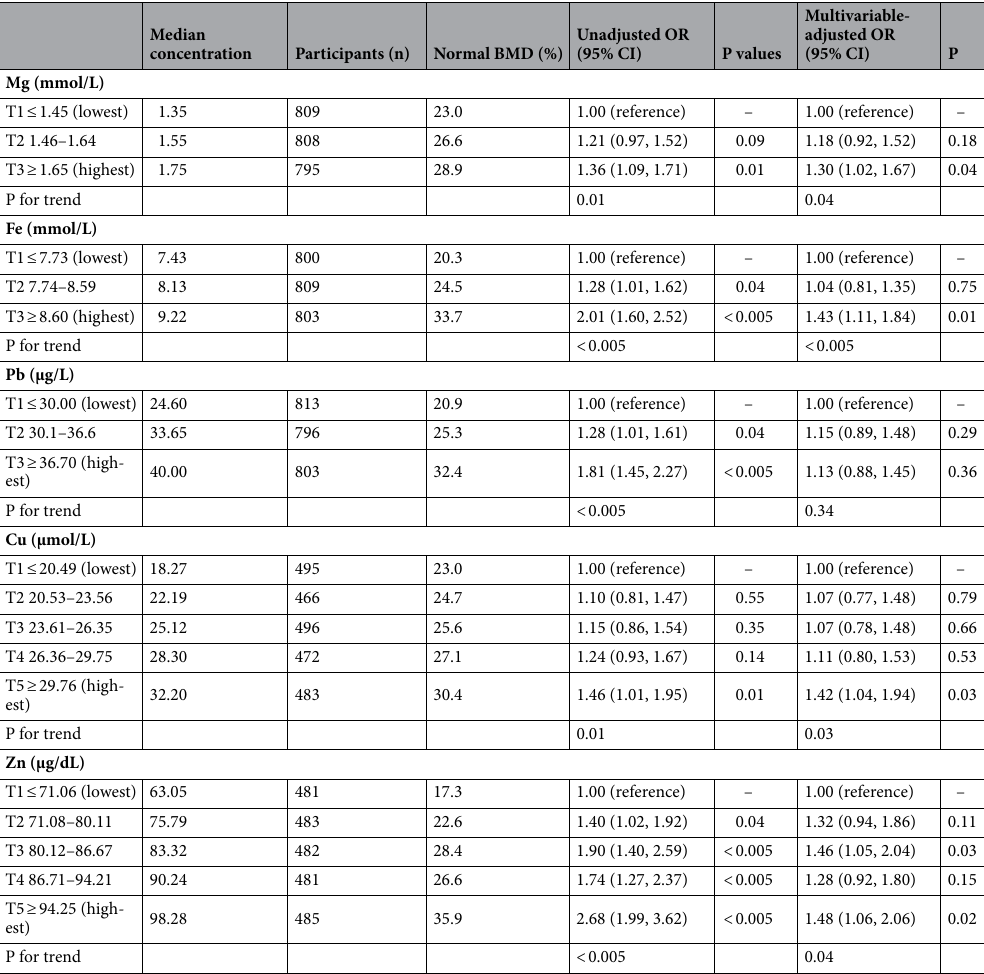
Table 3. Association between serum levels of trace elements and bone mineral density. Multivariable model was adjusted for age (continuous data), gender (male, female), body length (continuous data), weight (continuous data) and head circumference (continuous data). n number, BMD bone mineral density, Mg magnesium, Fe iron, Pb lead, Cu copper, Zn zinc, OR odds ratio, CI confidence